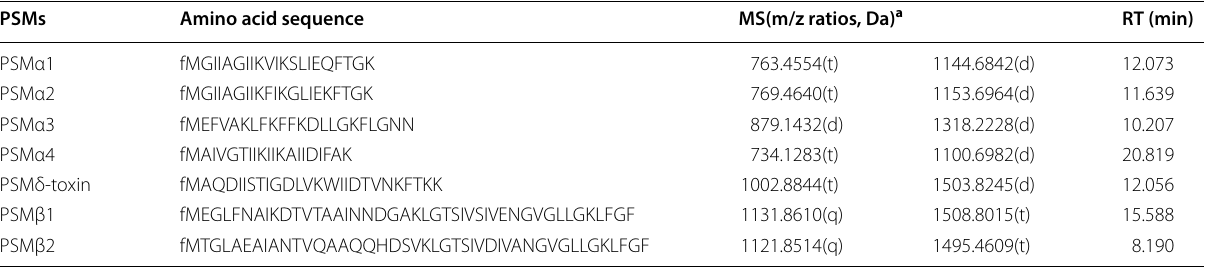
a (d), (t) and (q) respectively stand for doubly, triply and quadruply charged ions